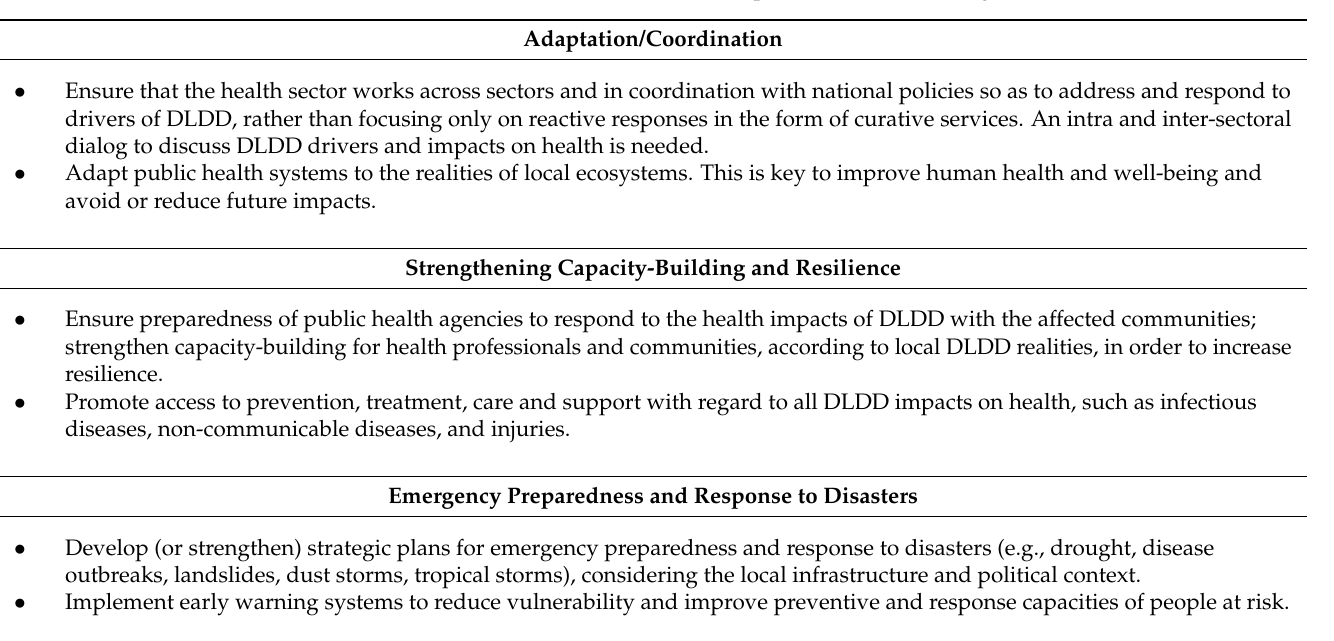
Table 3. Health sector actions are needed to respond to DLDD